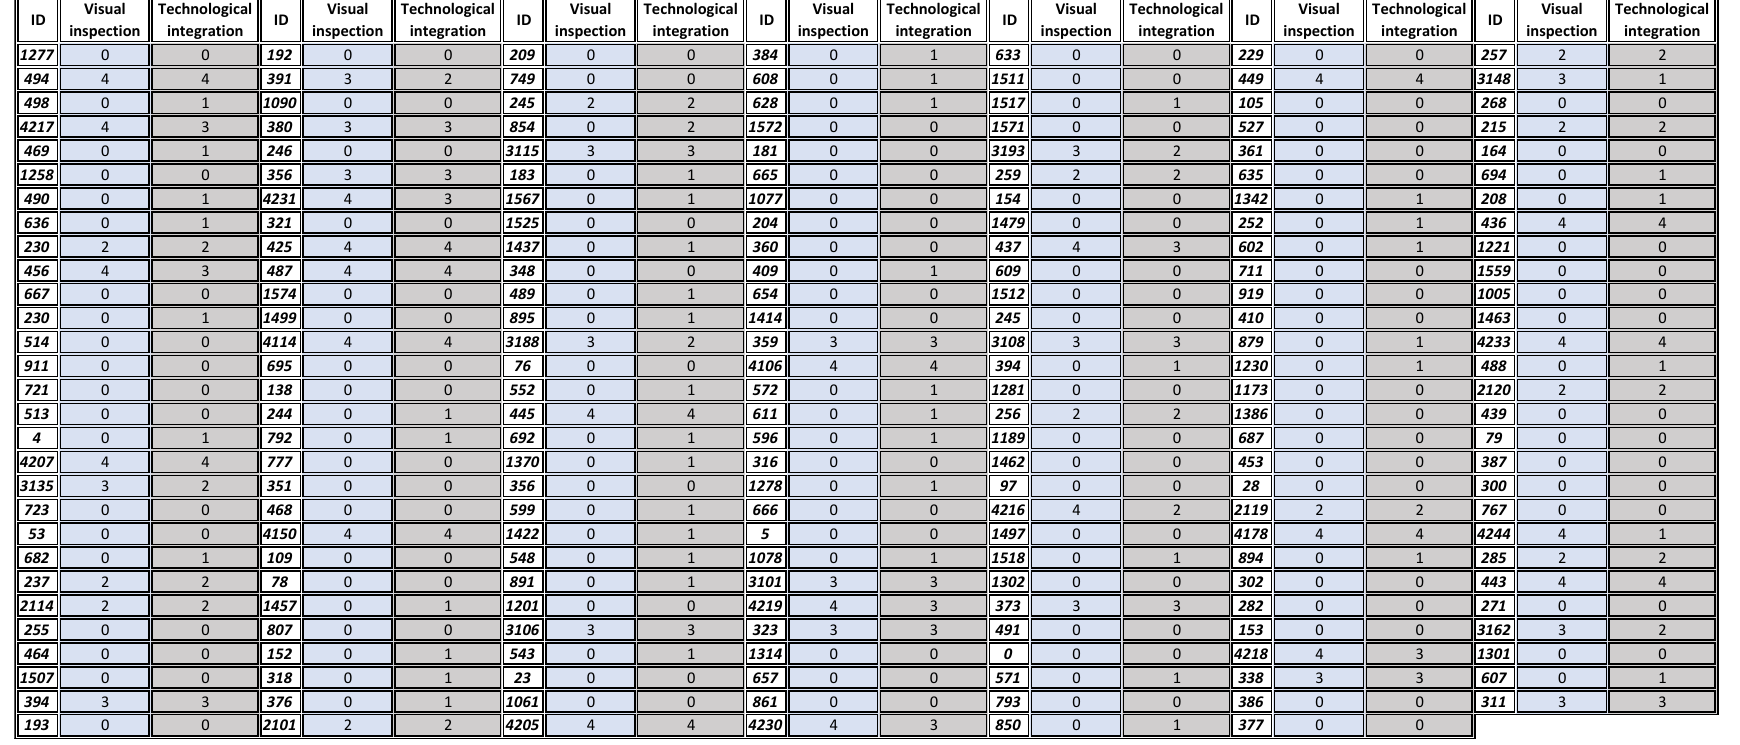
` Figure A1. Comparative statistical analysis table showing Visual Inspection VS Technological Integration with their respective sample